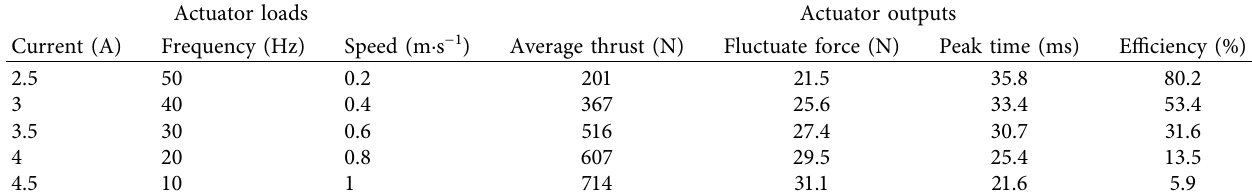
Figure 18: Energy feedback power of electromagnetic actuator under different Table 4: Active characteristic of the actuator under different loads.